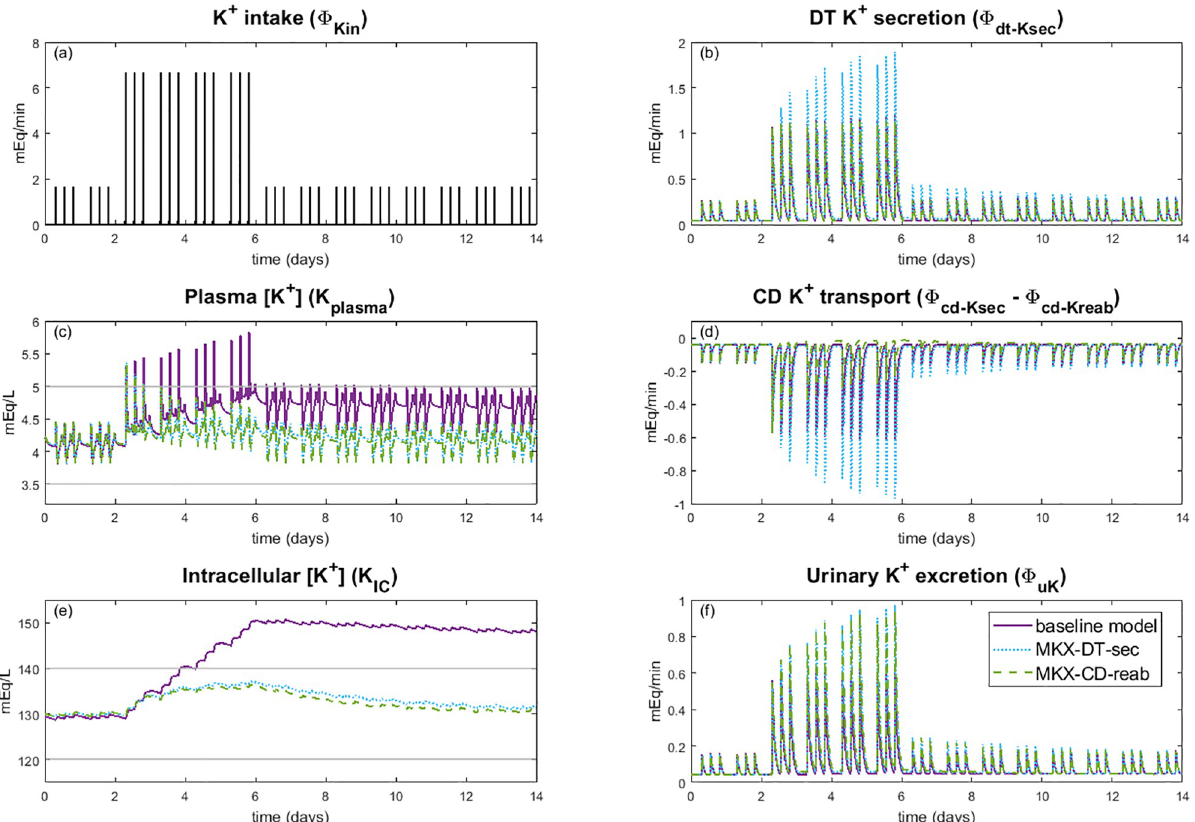
Fig 8. Impact of muscle-kidney cross talk on K + loading. Simulation results for K + loading experiments for the baseline model and muscle-kidney cross talk simulations (Case MKX-DT-sec and Case MKX-CD-reab). Potassium intake (A) is the same for all three simulation types. Note that Case MKX-CD-sec is not plotted since it had little impact from the baseline model results. Horizontal grey line shows normal range for plasma K + concentration (C) and intracellular K + concentration (E) . CD: collecting duct, DT: distal tubule